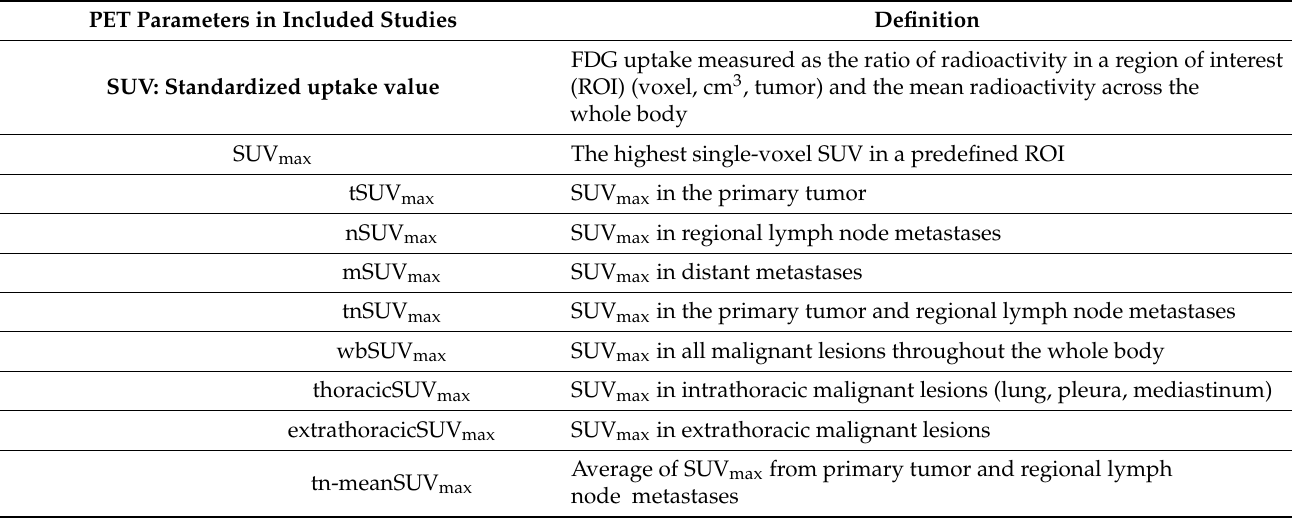
Table 1. PET parameters. Definitions of PET parameters used in the included studies. PET Parameters in Included Studies Definition